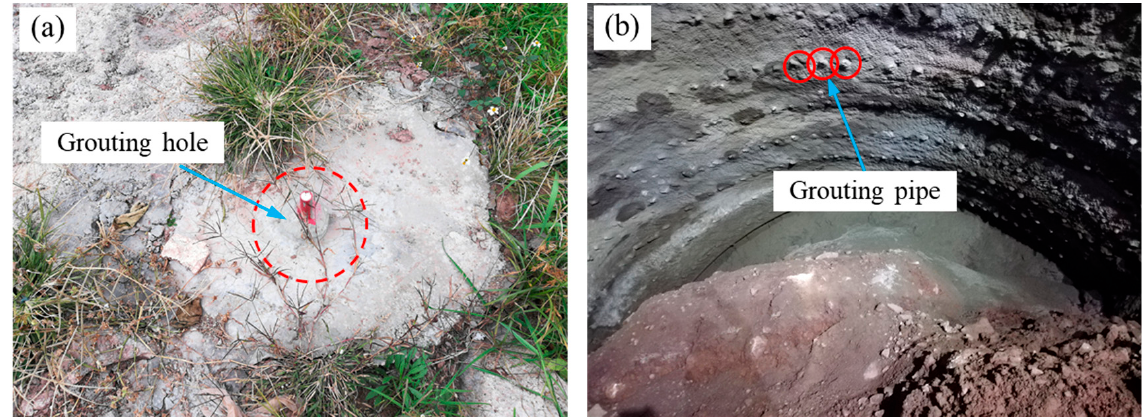
Figure 9. Photographs of grouting. ( a ) Surface grouting; ( b ) grouting in tunnel.